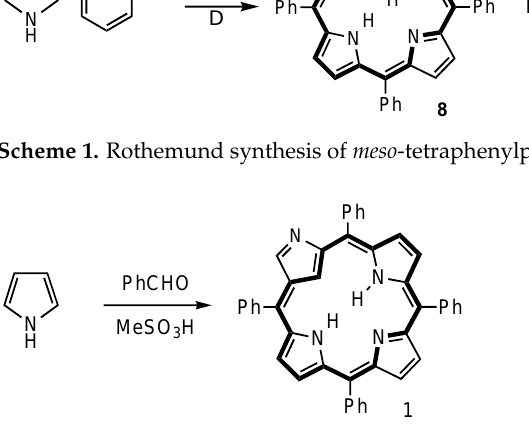
Scheme 2. Synthesis of Tetraphenyl N-Confused Porphyrin.